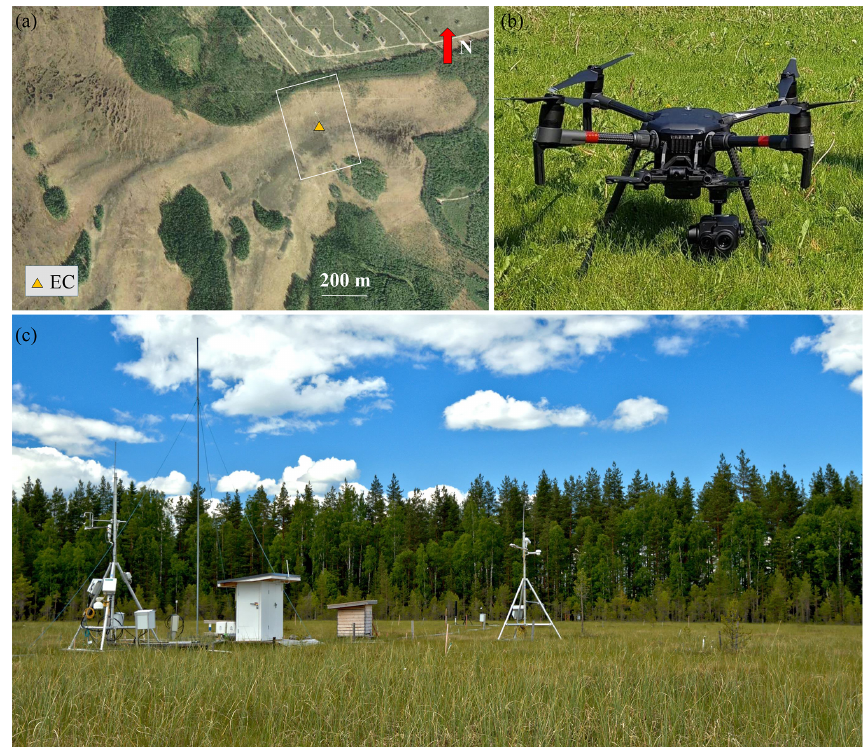
Figure 1. (a) Satellite view of the region surrounding the measurement site (61.832 ◦ N, 24.193 ◦ E). The area imaged by the drone is shown with the white box. A © Google Earth screenshot is used. (b) The UAS consisting of a DJI Matrice 210 v2 drone and a DJI Zenmuse XT2 thermal/RGB camera. (c) Siikaneva fen ICOS site captured at the peak of the sedge leaf area, viewed towards the northwest. The EC tower is on the extreme left. Table 1. Flight metadata. The times specified are